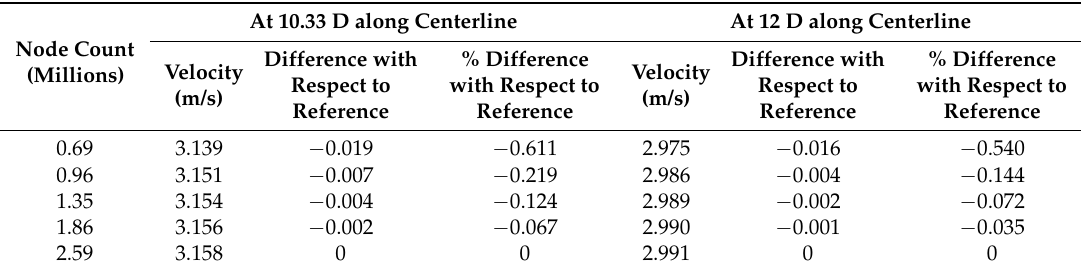
Table 1. Grid independence